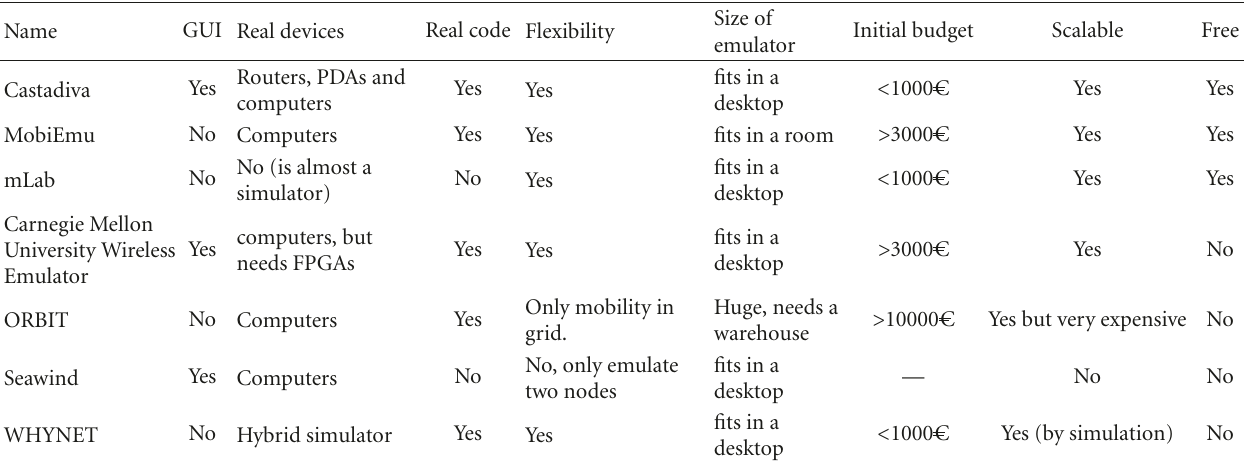
Table 1: Comparative of existing